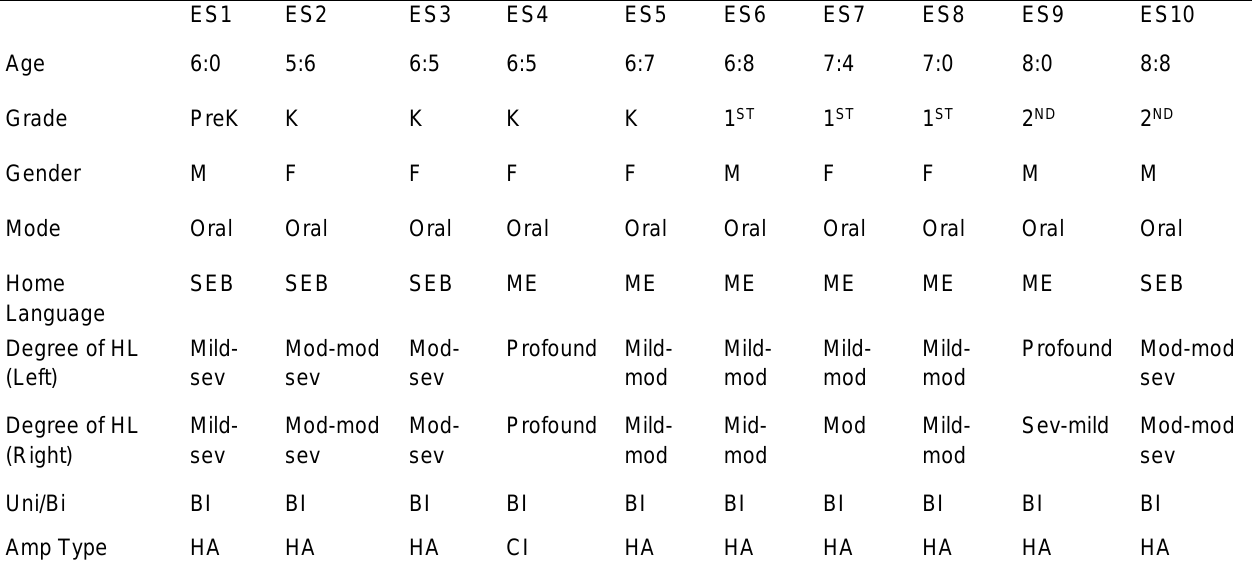
Table 1. Profiles for Telepractice Group